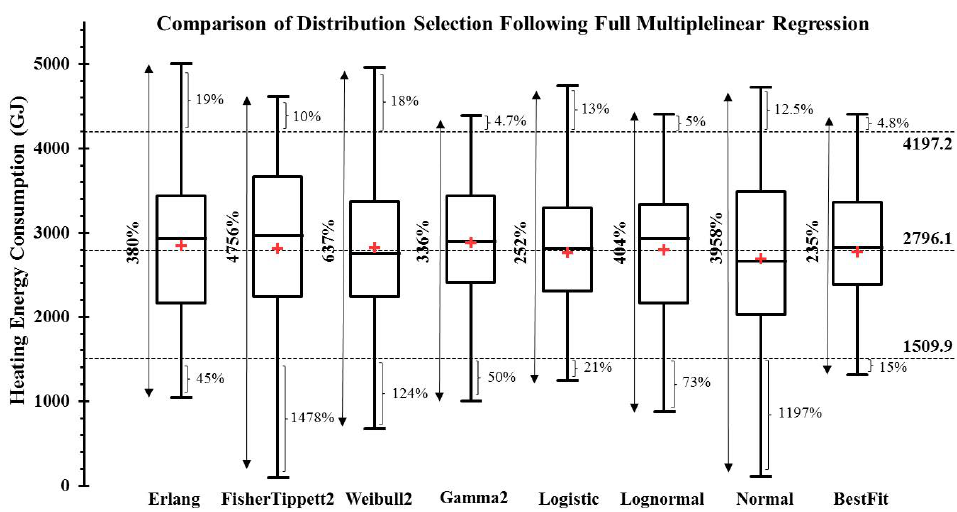
Figure 6. Heating energy use probability density functions when following a full multiple linear regression model and comparing selection of various input average annual weather variables distributions used in the uncertainty propagation